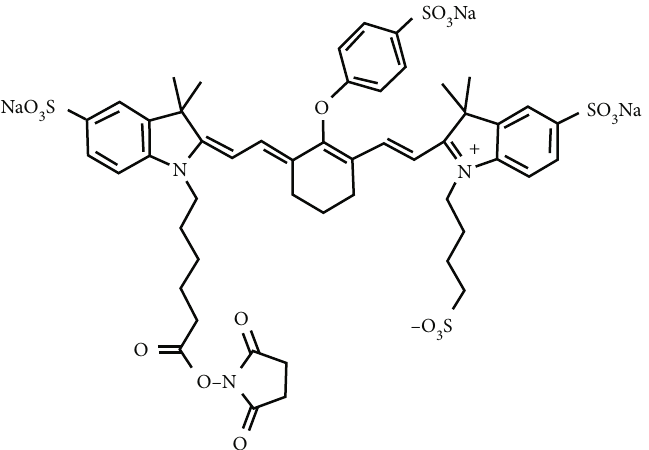
Figure 8: Molecular structure of IRDye800CW NHS ester